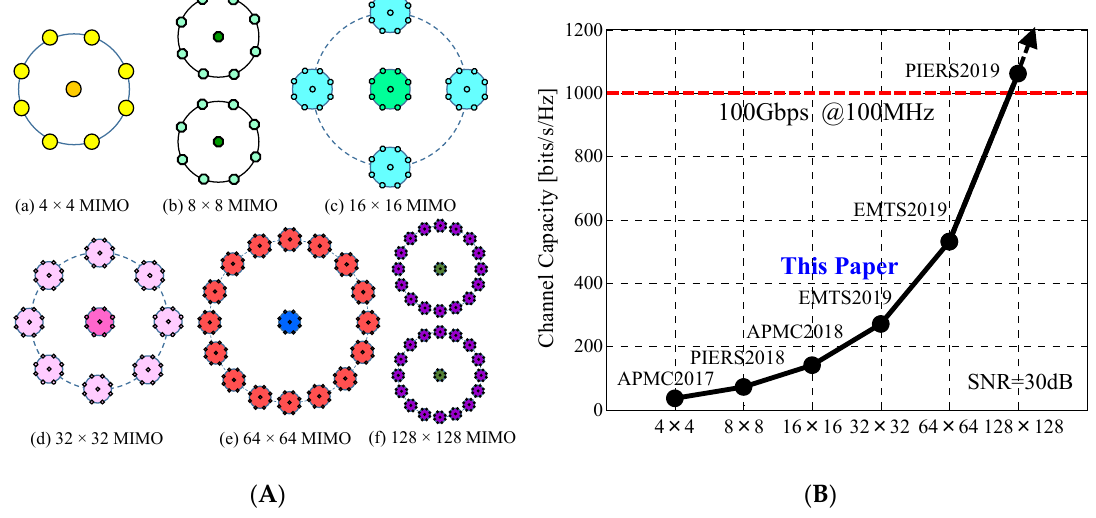
Figure 2. A big challenge toward 100 Gbps channel capacity. ( A ) A family of daisy chain MIMO antennas. ( B ) History of the development.